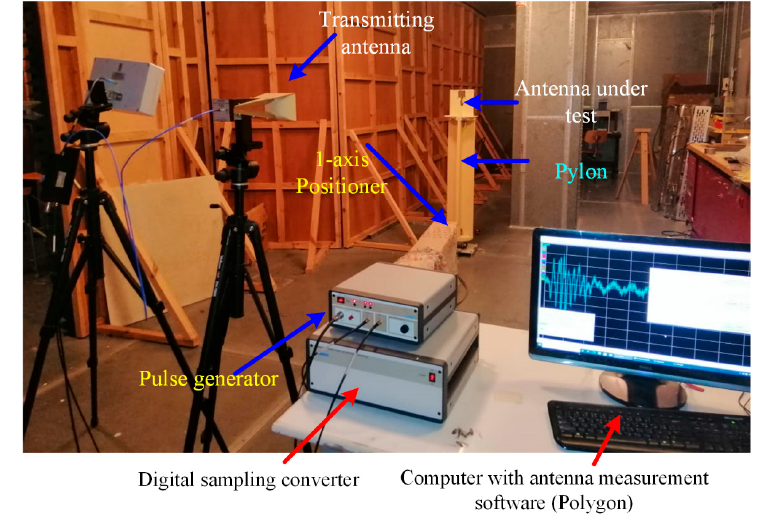
Figure 19. Simulated and measured return loss (S 11 ) of the single-fed dual-band slotted square antenna.